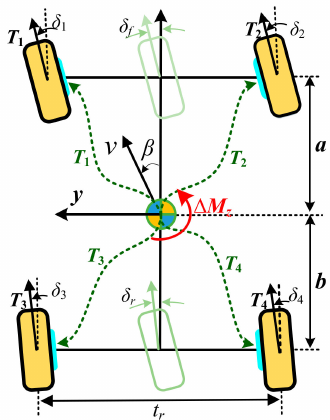
Figure 6. Allocation of virtual control